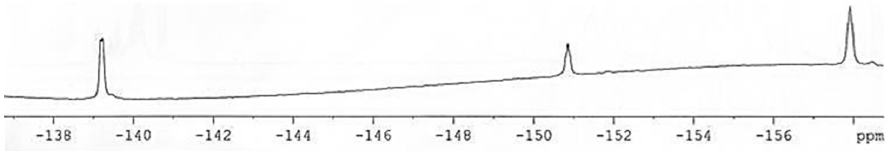
Figure 3. 19 F NMR spectra (in CDCl 3 ) of the P3HT 0.6 -(P3HT-5F) 0.4 .